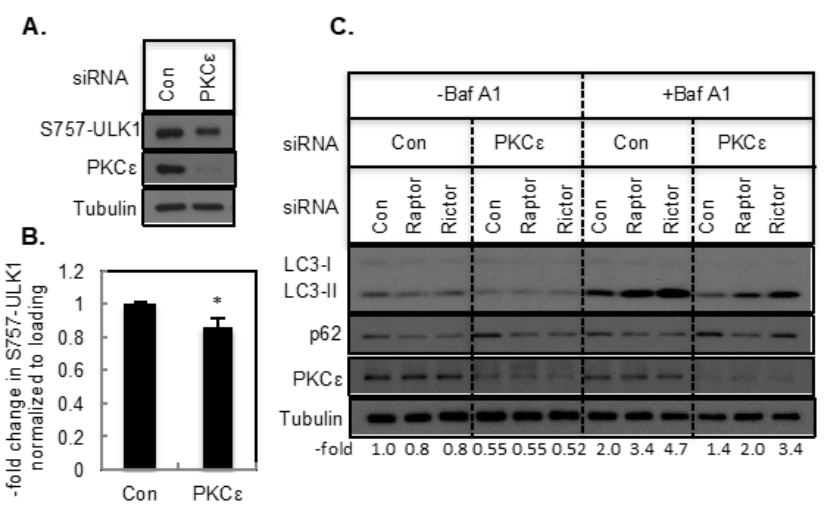
Figure 7. The effect of PKC ε , Raptor and Rictor knockdown on autophagy. T47D cells were transfected with control or PKC ε siRNA. ( A ) or double transfected with Raptor and Rictor siRNA ( B ) Bar graph represents mean ± S.E. *, p ≤ 0.05 ( n = 11). (C) Western blot analyses were performed with indicated antibodies. with indicated